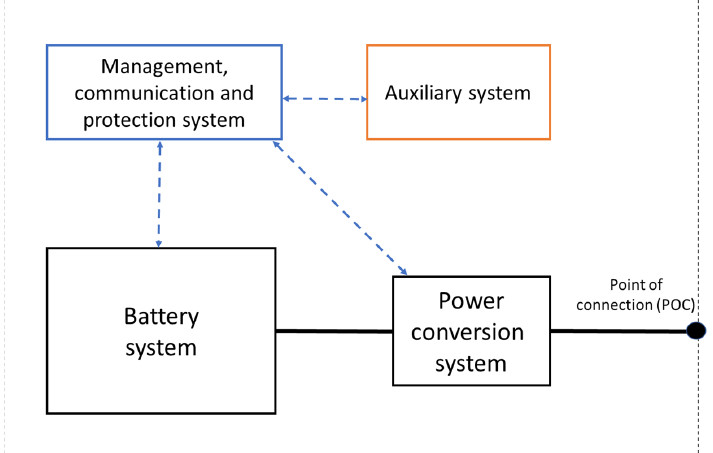
Figure 1. Scheme of an electrochemical energy storage system (EESS) and its main parts: battery system, management, communication and protection system, auxiliary system, and power conversion system. The position of the primary point of connection (POC) to the grid is highlighted [10].